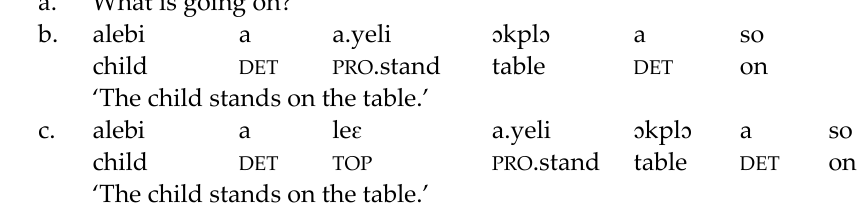
‘The child stands on the table.’